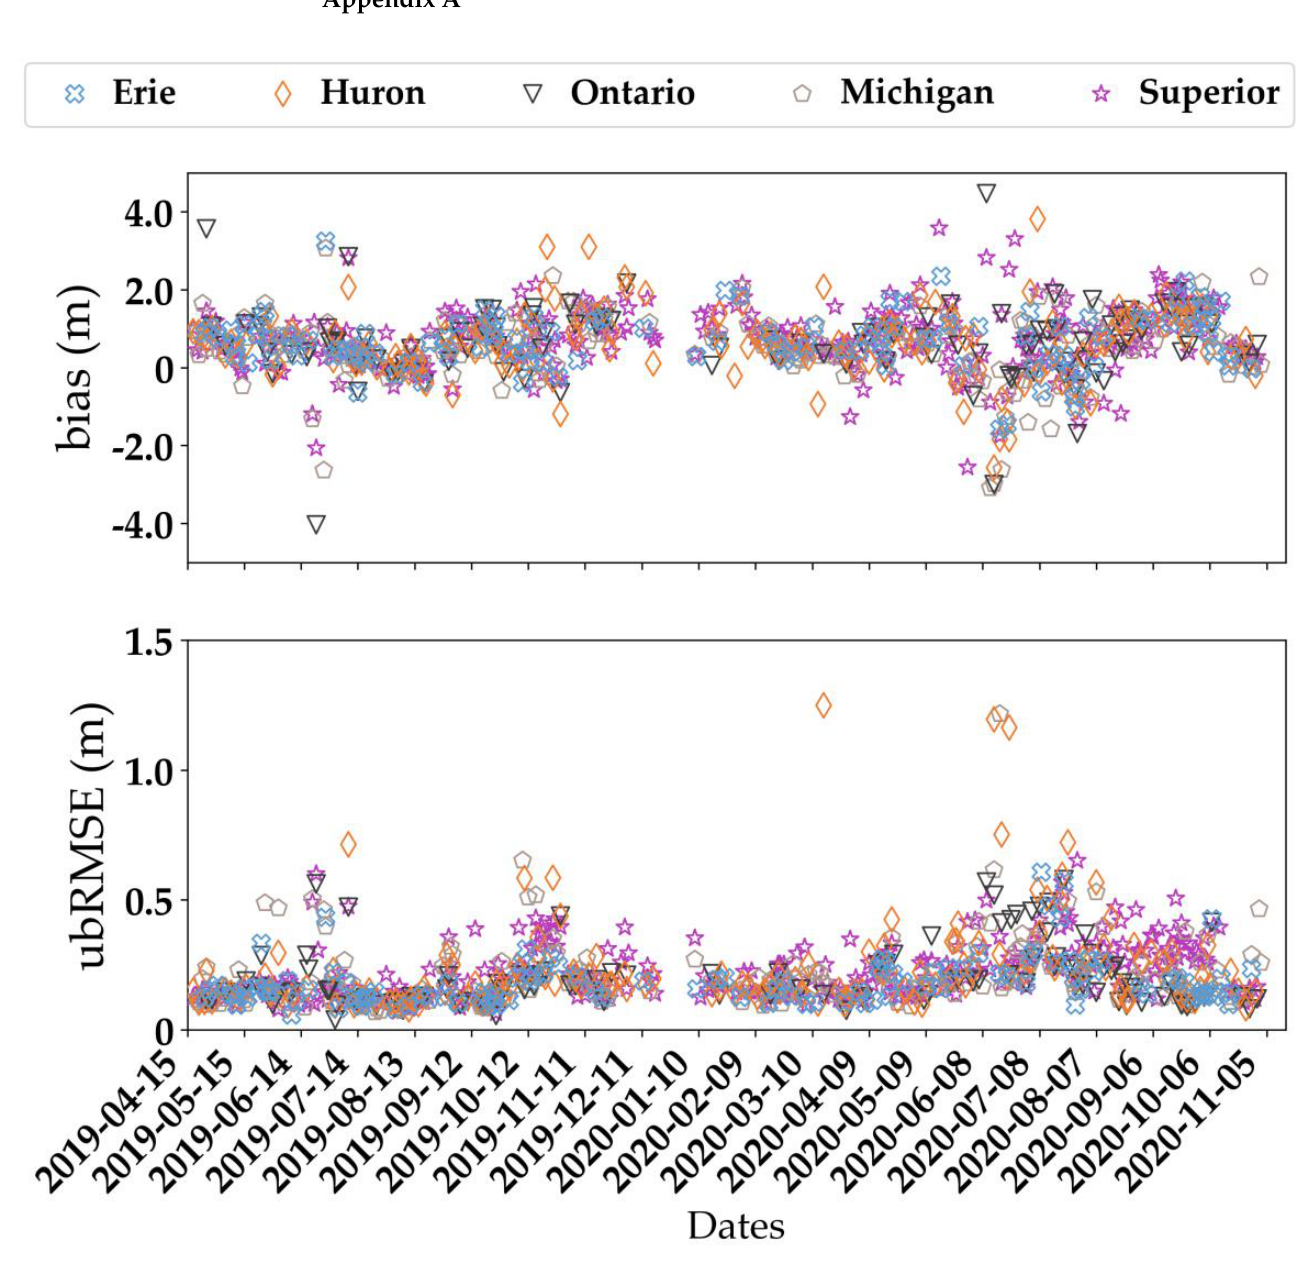
Figure A1. Bias (m) and ubRMSE (m) of GEDI acquisition time series across the five lakes. Each dot represents the bias or ubRMSE of multiple GEDI shots from the same track (i.e., shots acquired on the same date with the same beam).